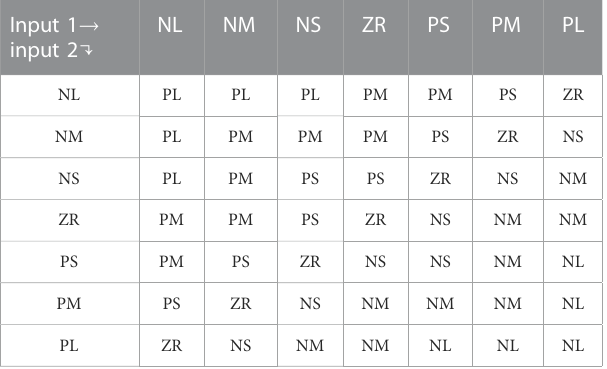
TABLE 1 Control rules of the MFO-SFL-based PIDD 2 controller.